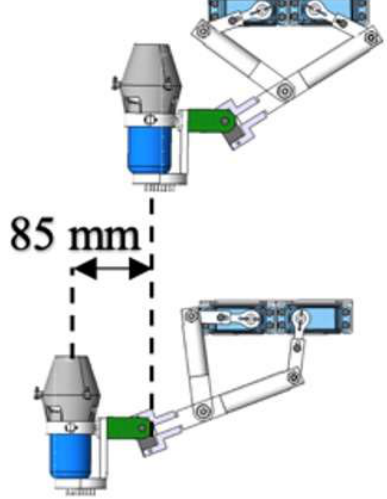
Figure 3. Structure of the diamond parallel leg.